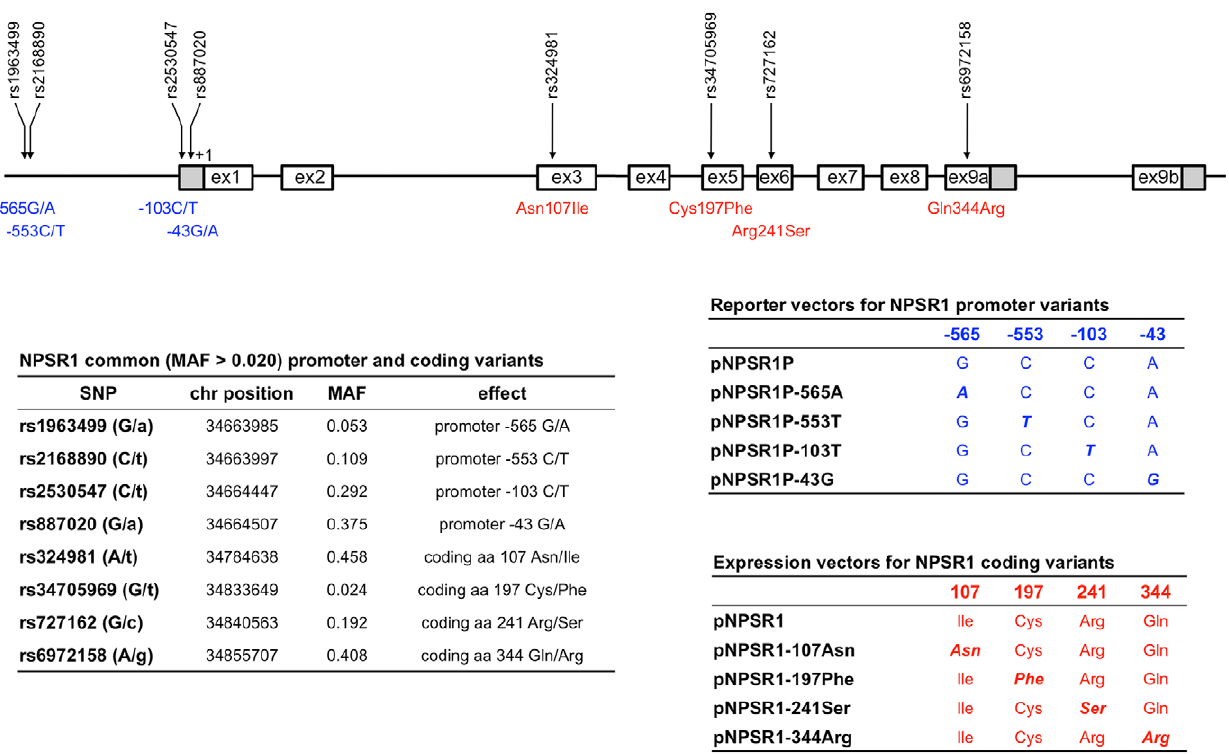
Figure 1. NPSR1 polymorphisms characterized in this study, and vector constructs used for their functional analysis. Top: NPSR1 common (minor allele frequency [MAF] . 0.02) promoter and coding SNPs and their location in the gene region. Left: Chromosomal position, MAF, and functional effect of NPSR1 SNPs (minor alleles in lower case). Right: Vectors used to functionally characterize NPSR1 promoter (top) and coding (bottom) SNPs. For coding polymorphisms, a Myc-tagged version of each construct has also been produced for the experiments of immunofluorescence and FACS analysis.